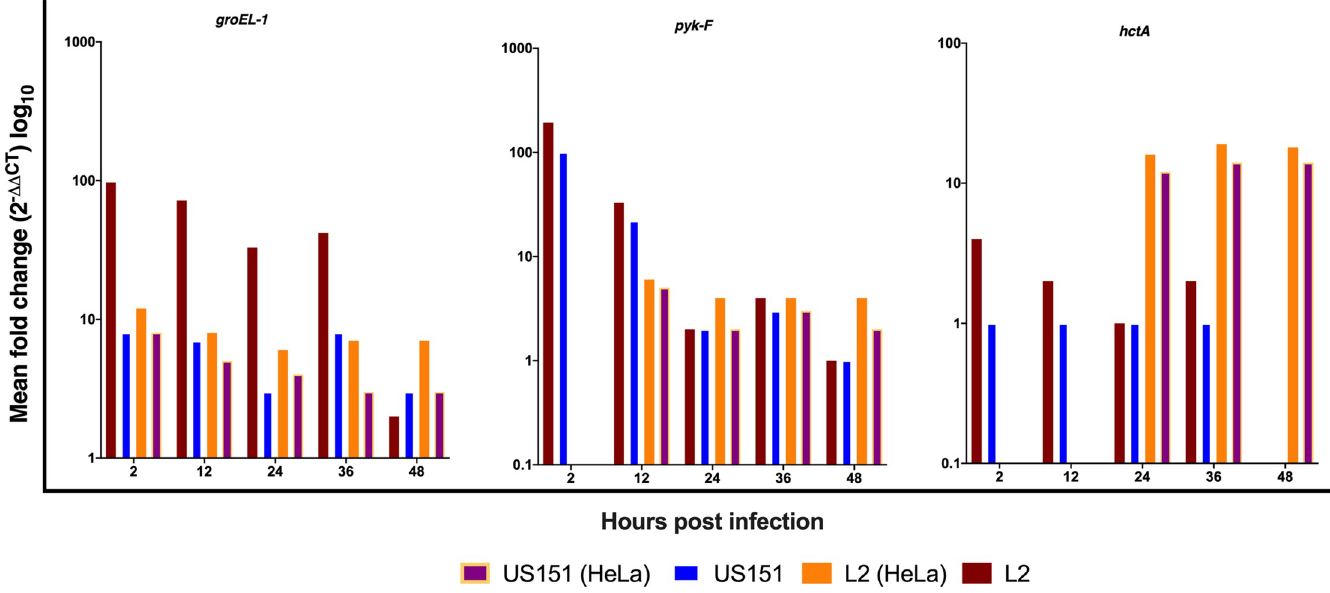
Fig 2. The expression groEL-1 , pyk-F and hctA genes of C . trachomatis reference strain L2 434 and clinical isolates US151 (L2) and serovar E at 2, 12, 24, 36 and 48 hpi in HaCaT and HeLa cells at 37˚C. Bar charts representing the mean fold difference (2 - ΔΔ CT ) of genes and the results are based on experiments carried out three times in